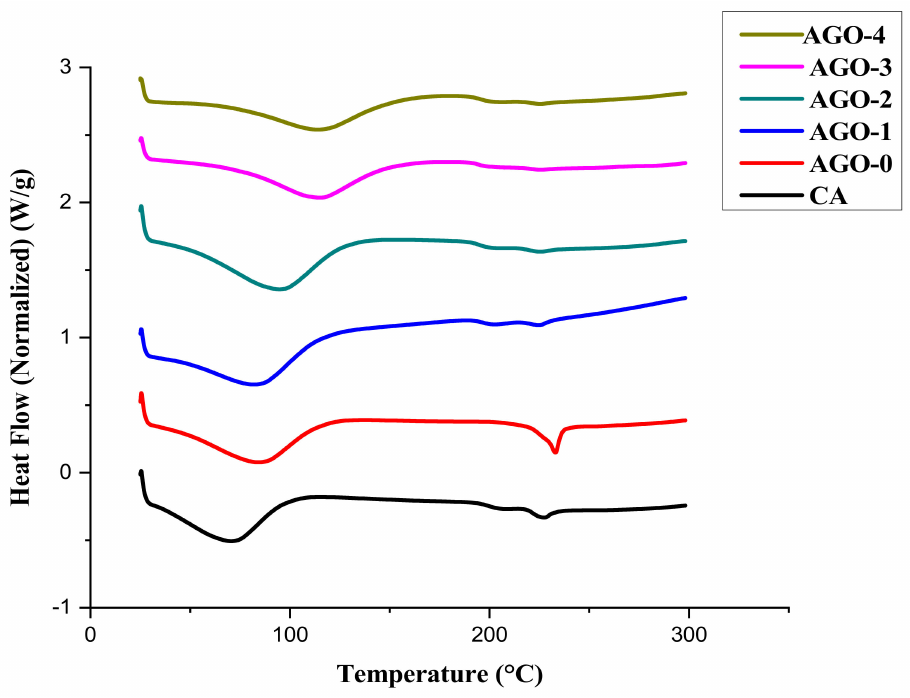
Figure 8. DSC of AGO